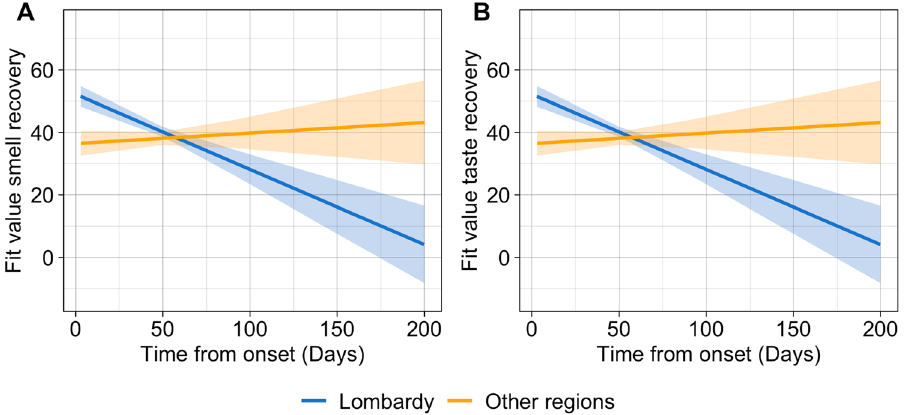
Figure 4. Representation of significant interaction effects of the regression models. Fitted lines of the time from onset and region interaction effects on ( A ) smell recovery and ( B ) taste